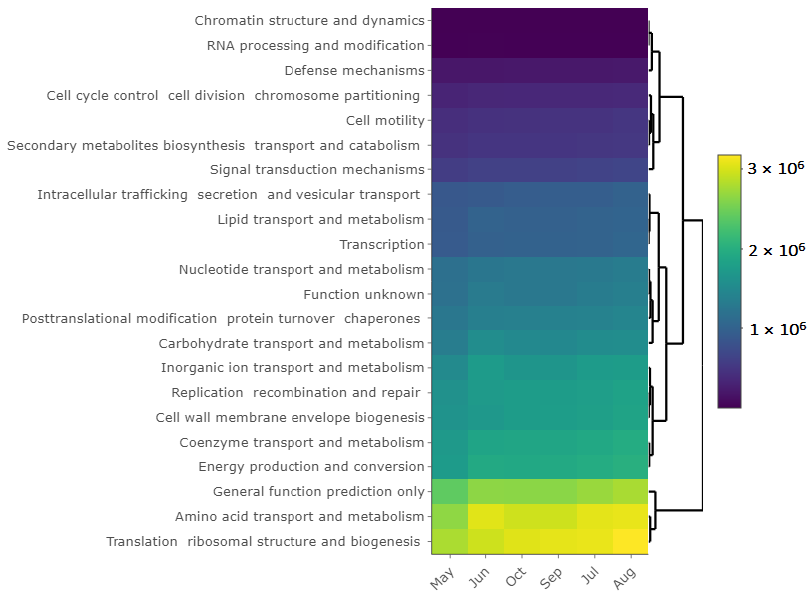
Figure 6. Bacterial community remains unchanged over seasons. ( a ) Stacked bar chart across the growing seasons; ( b ) PCoA showing beta-diversity using Bray – Curtis distance [PERMANOVA] F – value: 1.2403; R – squared: 0.17617; p – value < 0.217.